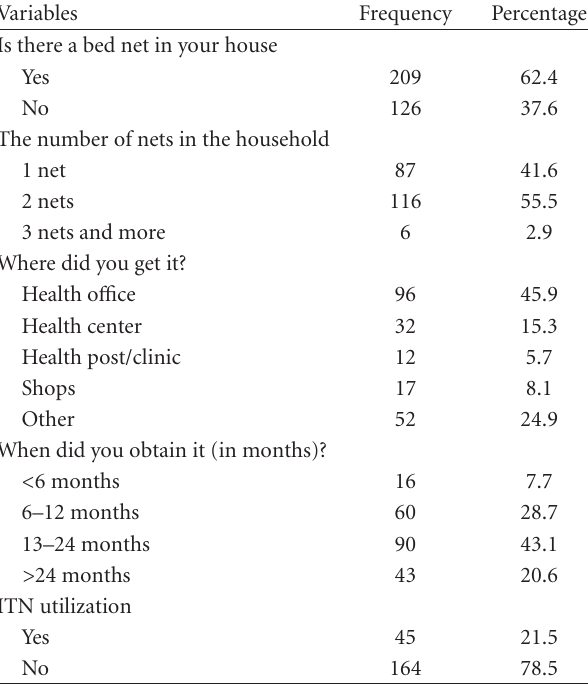
Table 2: Mosquito net ownership and utilization among respon- dents in Gursum district, Ethiopia,